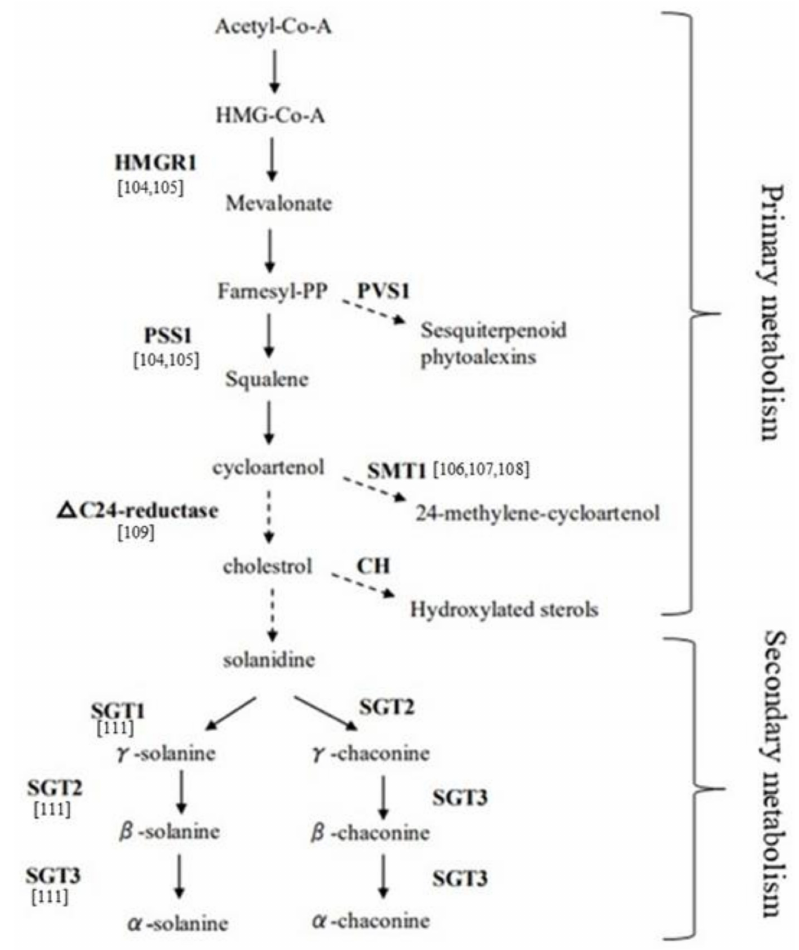
Figure 2. Glycoalkaloid biosynthetic pathway in potato (modified from Khan et al.)